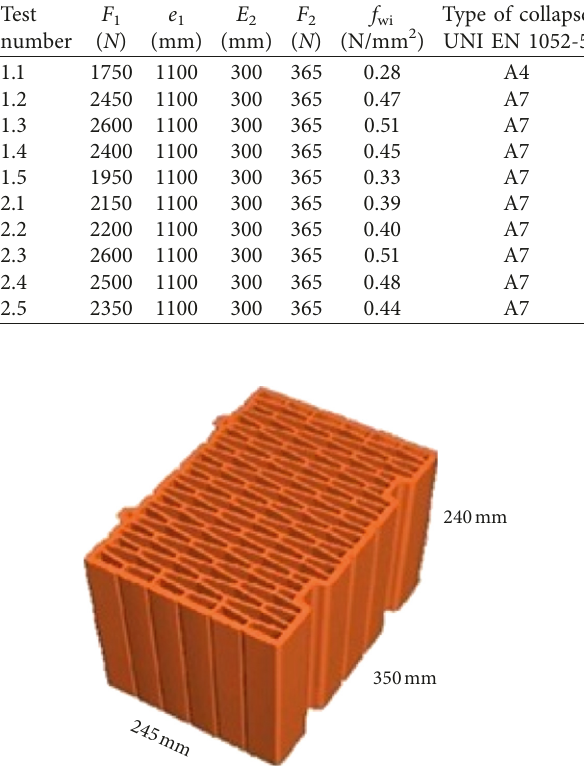
4: Module FV “MVI350” brick.